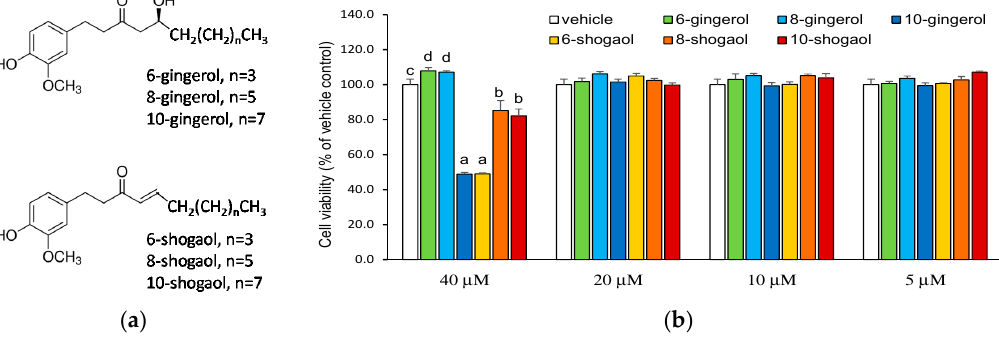
Figure 1. Chemical structure ( a ) and cytotoxic effect ( b ) of ginger phytochemicals. The phorbol 12-myristate 13-acetate (PMA)-differentiated THP-1 macrophages were treated with ginger phytochemicals at concentrations of 5~40 μ M for 24 h. The cell viabilities were then assessed with 3-(4,5-dimethyldiazol-2-yl)-2,5-diphenyl tetrazolium bromide (MTT) method. Data are expressed as the mean ± SD of triplicate independent experiments. Values of the ginger phytochemicals at concentration of 40 μ M with different superscript letters are significant different from one another ( p < 0.05).